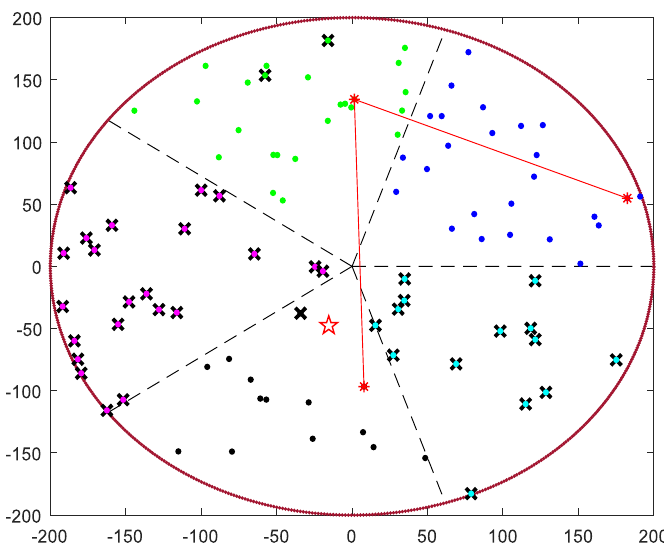
Figure 17. Uneven energy distribution between clusters.